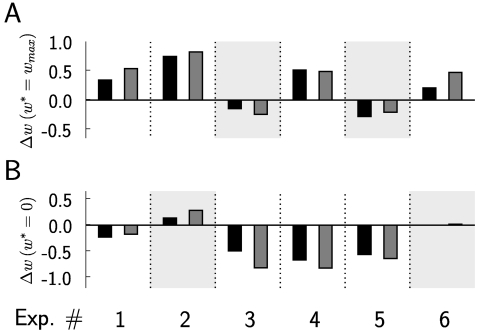
Test of the validity of the analytically derived conditions
13–15 on the relationship between parameters for successful
learning with reward-modulated STDP.Predicted average weight changes (black bars) calculated from Equation 22
match in sign and magnitude the actual average weight changes (gray
bars) in computer simulations, for 6 different experiments with
different parameter settings (see Table 1). (A) Weight changes for
synapses with . (B) Weight changes for synapses with . Four cases where constraints 13–15 are not
fulfilled are shaded in light gray. In all of these four cases the
weights move into the opposite direction, i.e., a direction that
decreases rewards.